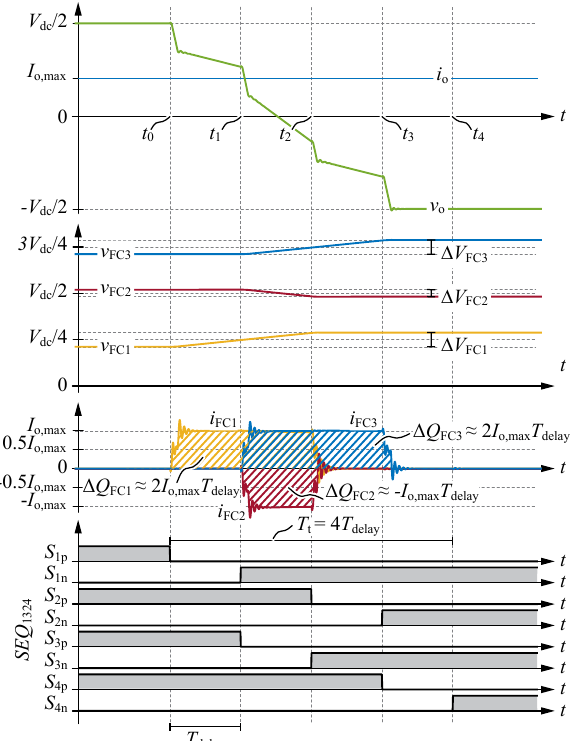
Figure 3. Simulation results for Q2L operation of the 5L-FCC with constant positive output current ( I o ) during the switching transition with negative slope of v o , exemplifying the effect of a non- consecutive sequence SEQ 1324 : Charging of FC 1 and FC 3 , discharging of FC 2